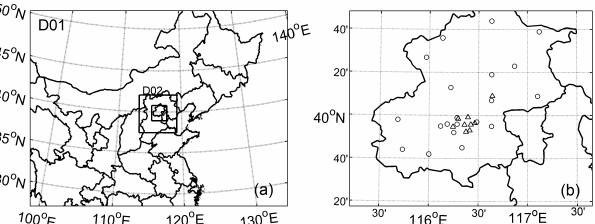
Figure 1. The model simulation domain (a) and observation sta- tion distribution (circles represent meteorological station; triangles represent environmental station) in the inner domain (b)